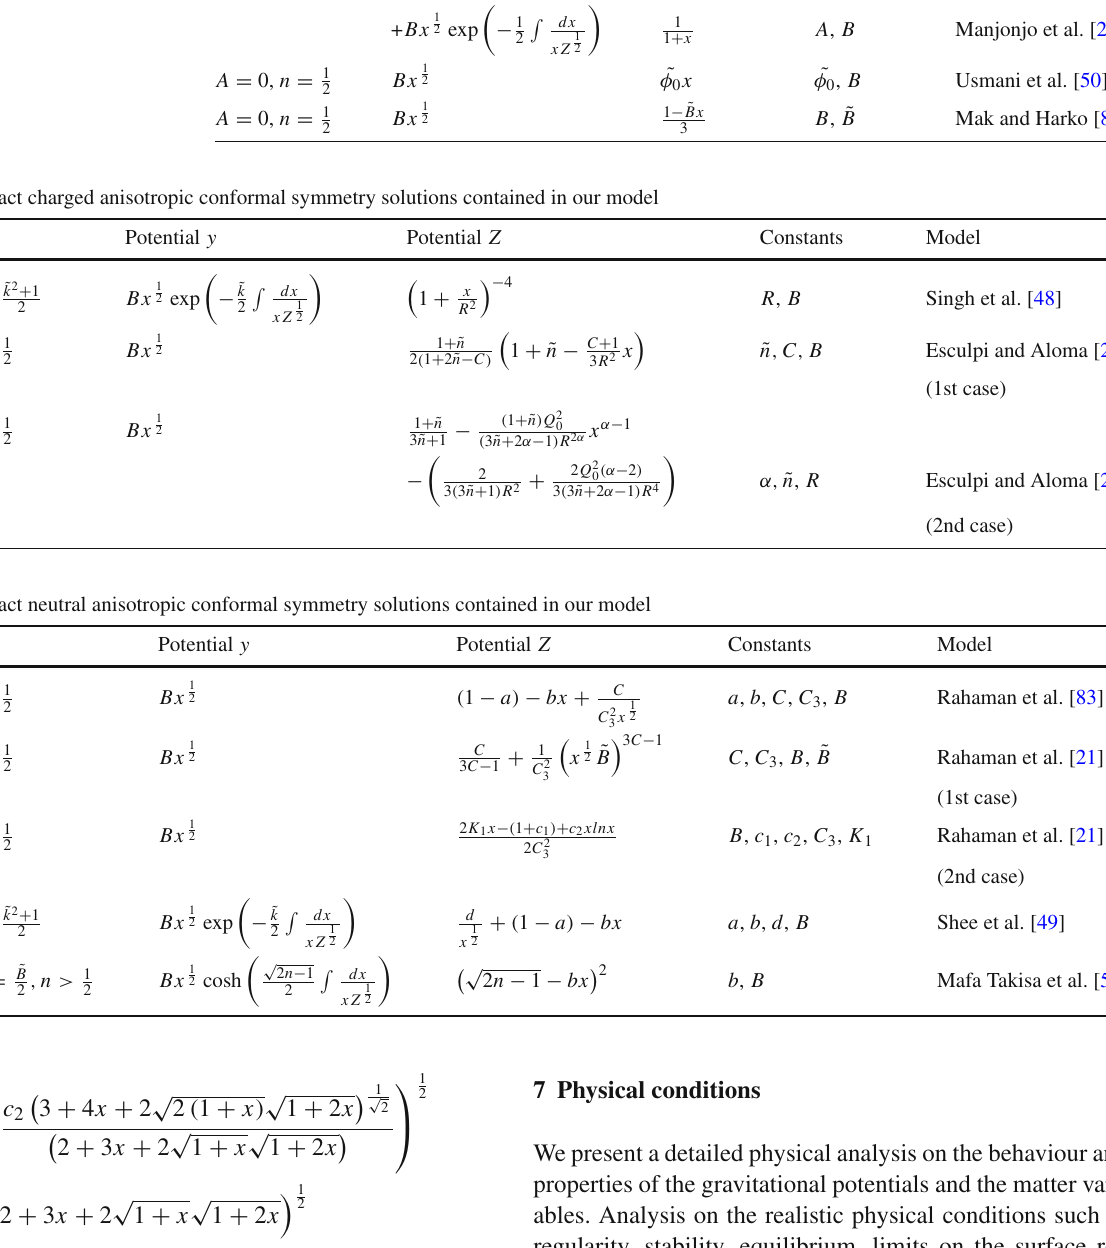
Table 1 Exact charged isotropic conformal symmetry solutions contained in our model